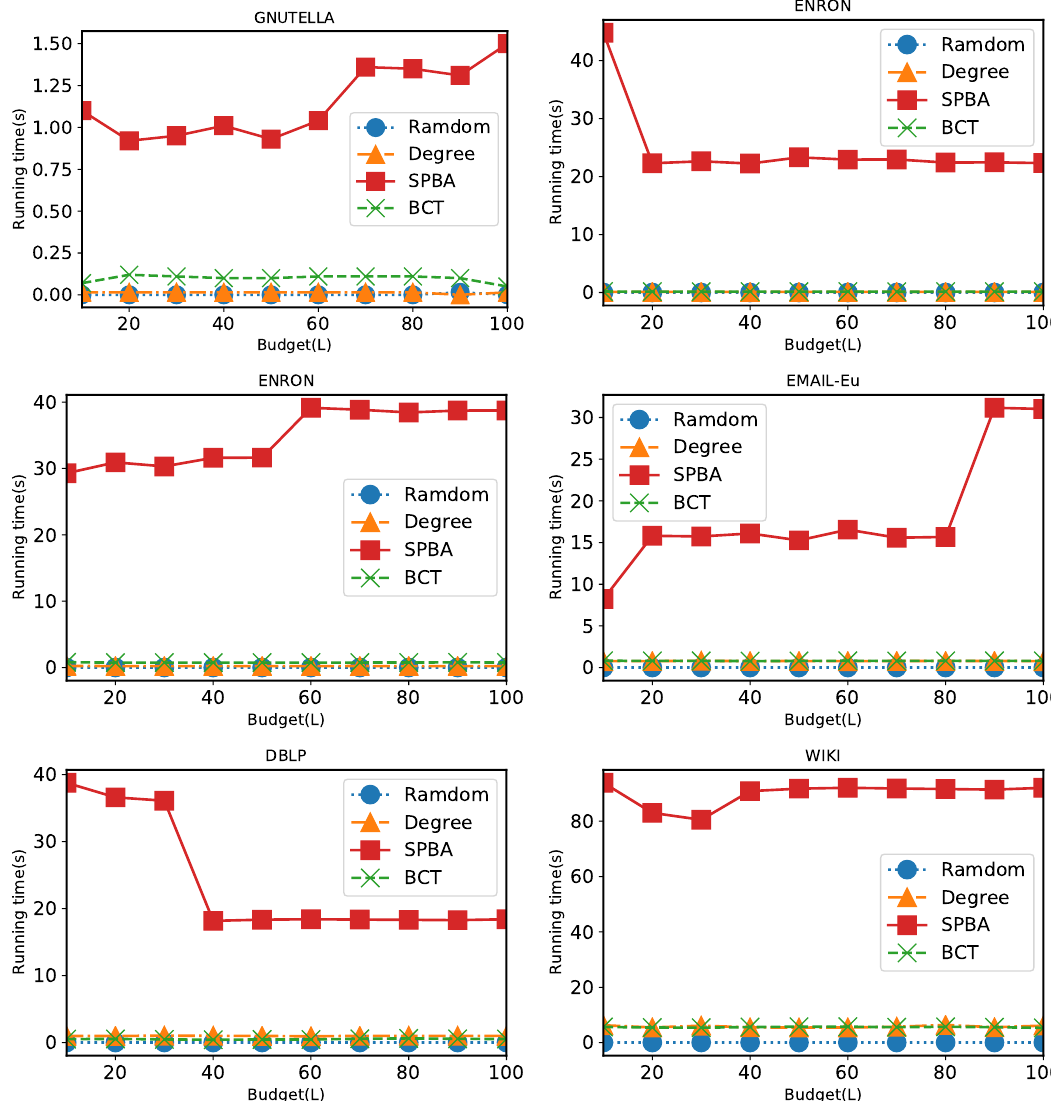
Figure 8. Running time of algorithms for BCIM